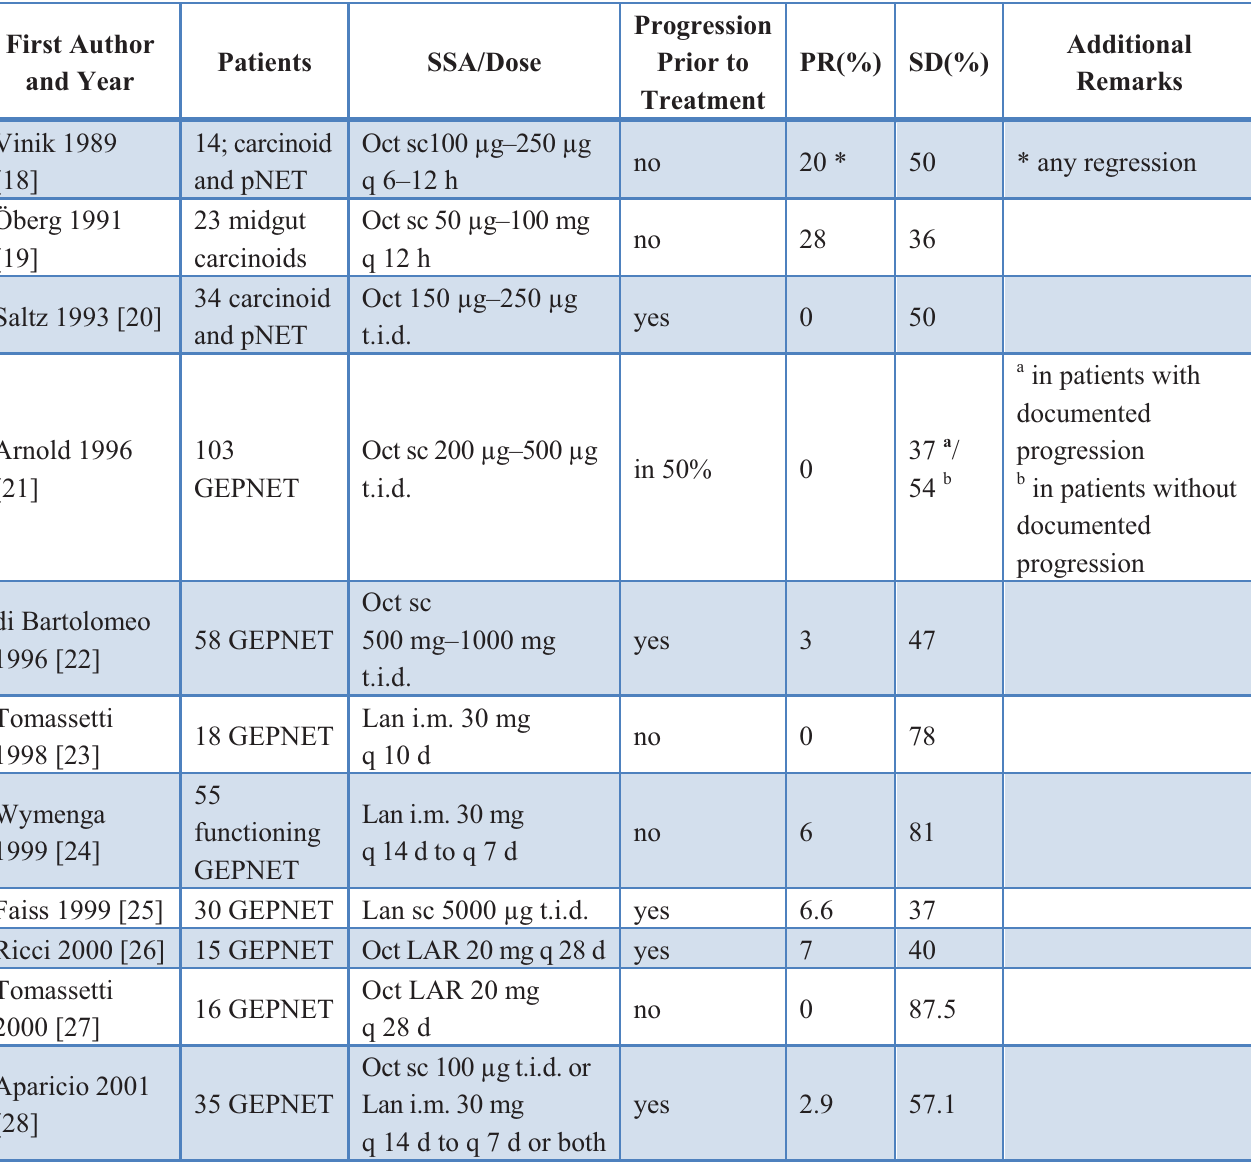
Table 2. Summary of studies reporting antiproliferative effects of somatostatin